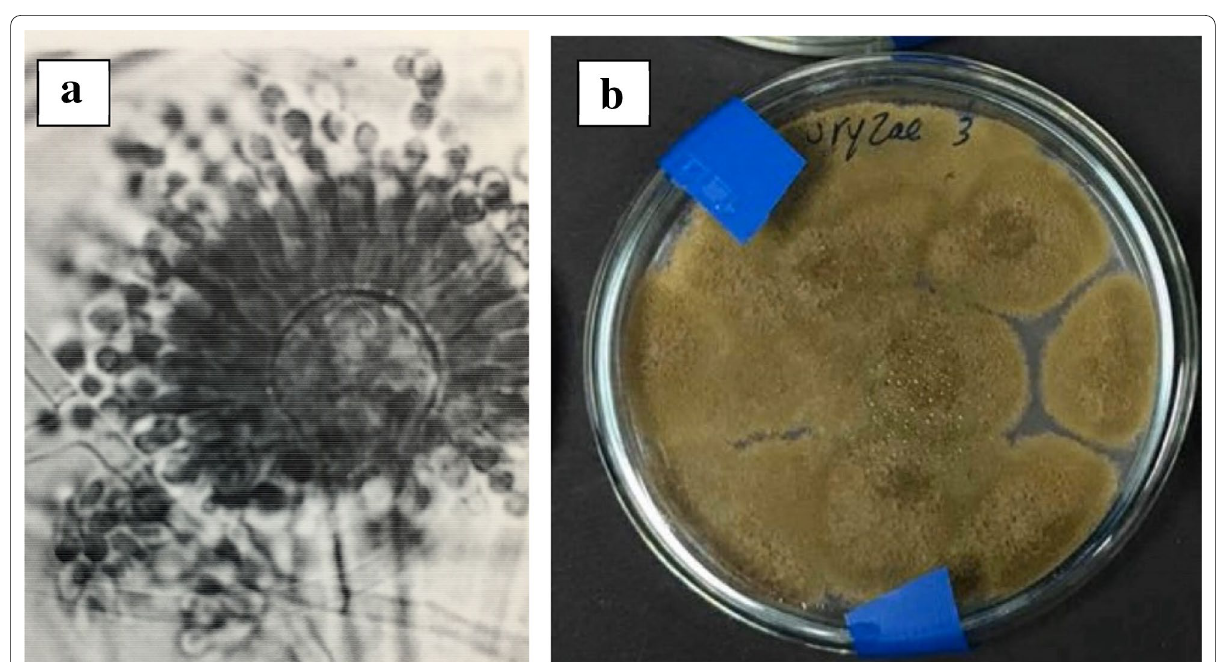
Fig. 1 Morphology of Aspergillus oryzae : A under microscope, B cultivated on potato dextrose agar